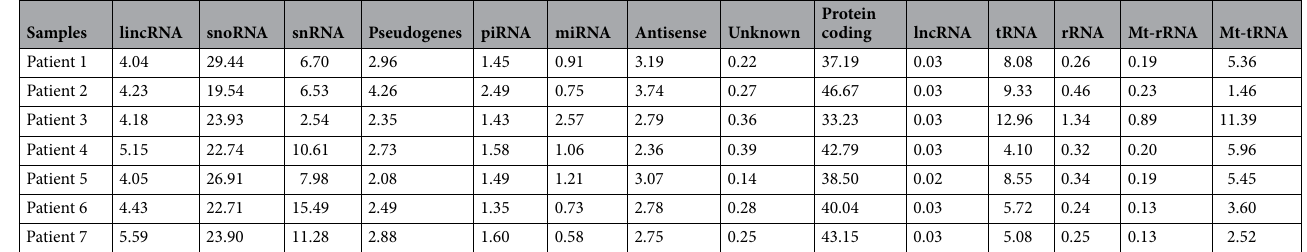
Table 8. Percentage human RNA reads mapped to gene biotypes per sample, as annotated in the Homo sapiens GRCh38.96, as well as tRNA annotations from UCSC Genome Browser, piRNA annotations from